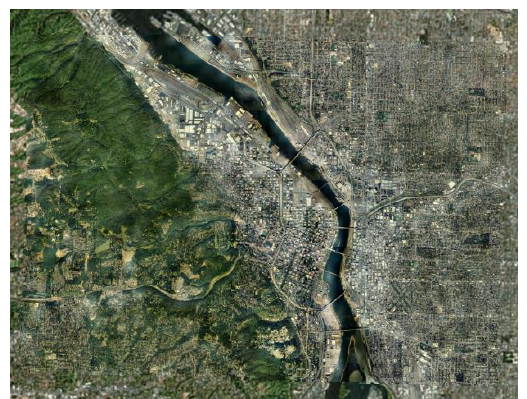
Fig.4.3 Color balance result: Color Grid Model using external target image.